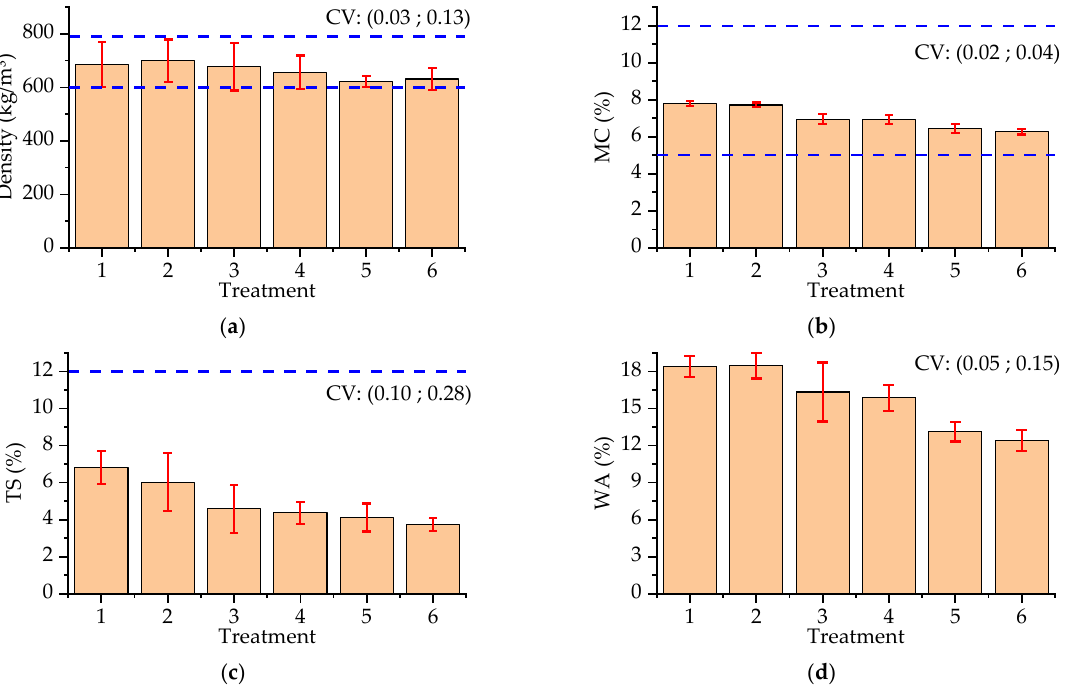
Figure 5. Physical properties results investigated: ( a ) Density, ( b ) Moisture content (MC), ( c ) Swelling after 24 h (TS), ( d ) Water absorption (WA). Note: The dashed lines represent the values defined by the normative limits, whiskers red lines the Standard deviation, and CV the Coefficient of Variation .